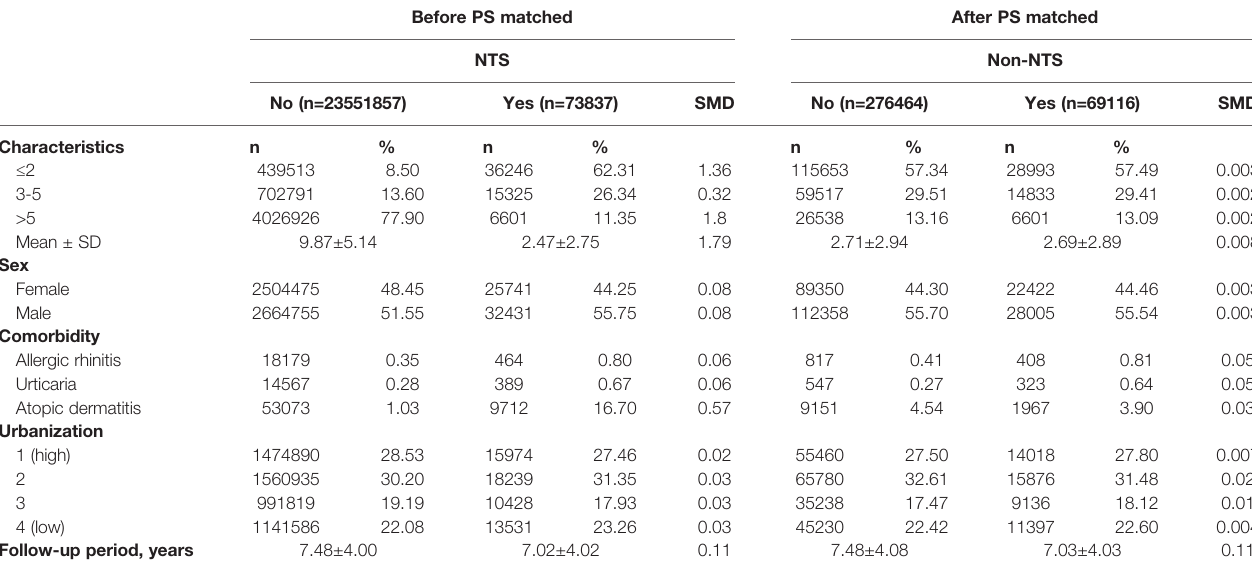
TABLE 1 | Baseline characteristics of patients with and without non-typhoidal Salmonella (NTS) infection.